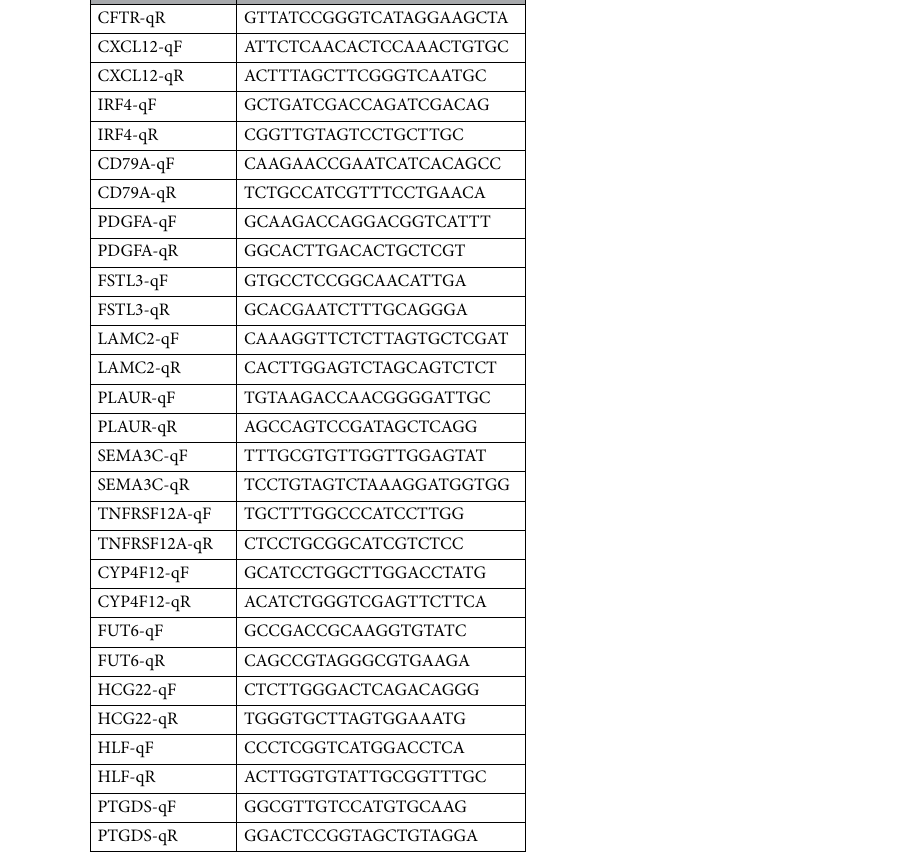
Table 1. Primer sequences used in